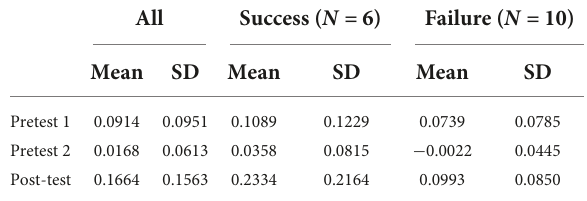
N =16. Mean cerebral blood flow and the standard deviation for the four ROI channels (mM · mm). TABLE 7 Solving time. All Success ( N =